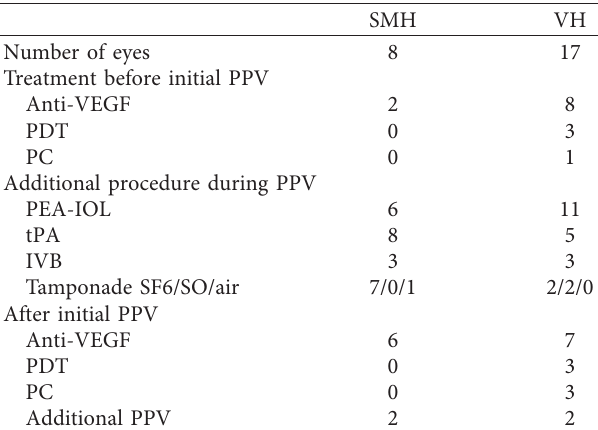
Table 2: Additional procedures during initial PPV and treatments before and after initial